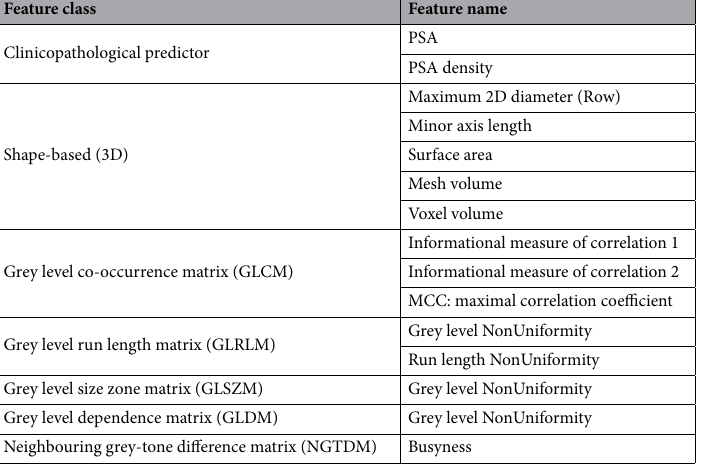
Table 3. Summary clinicopathological and T2WI-derived radiomic features comprising the best-performing predictive model of prostate cancer progression on active surveillance developed using the Wilcoxon signed rank test and k-nearest neighbours algorithms for feature selection and classification, respectively.